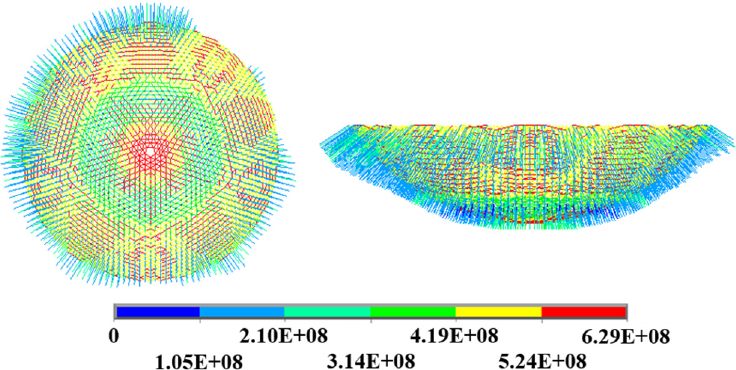
Figure 15. Stress diagram of the cable-net structure after the form deformation.